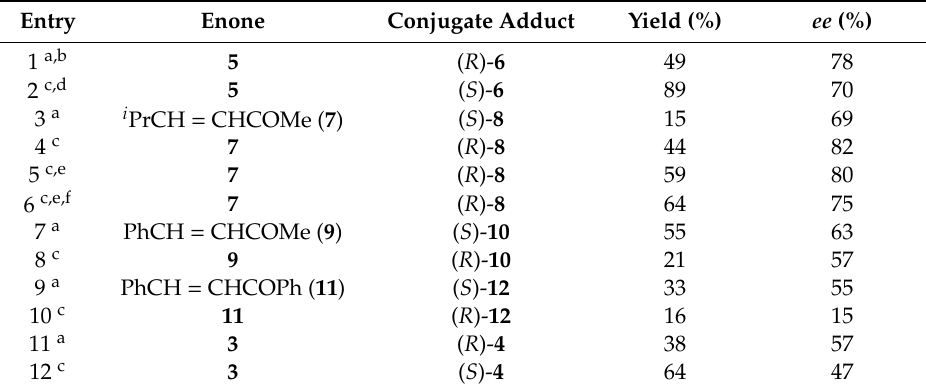
Table 7. Exploring substrate